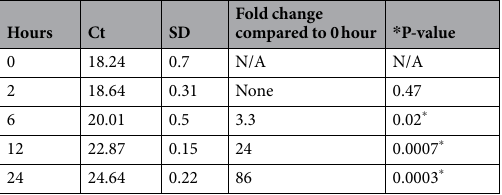
Table 1. E . chaffeensis 16S rRNA assessed for the RC form following different times points of incubation in the axenic media. ( * refers to significant fold change at different time points compared to 0 h value.)